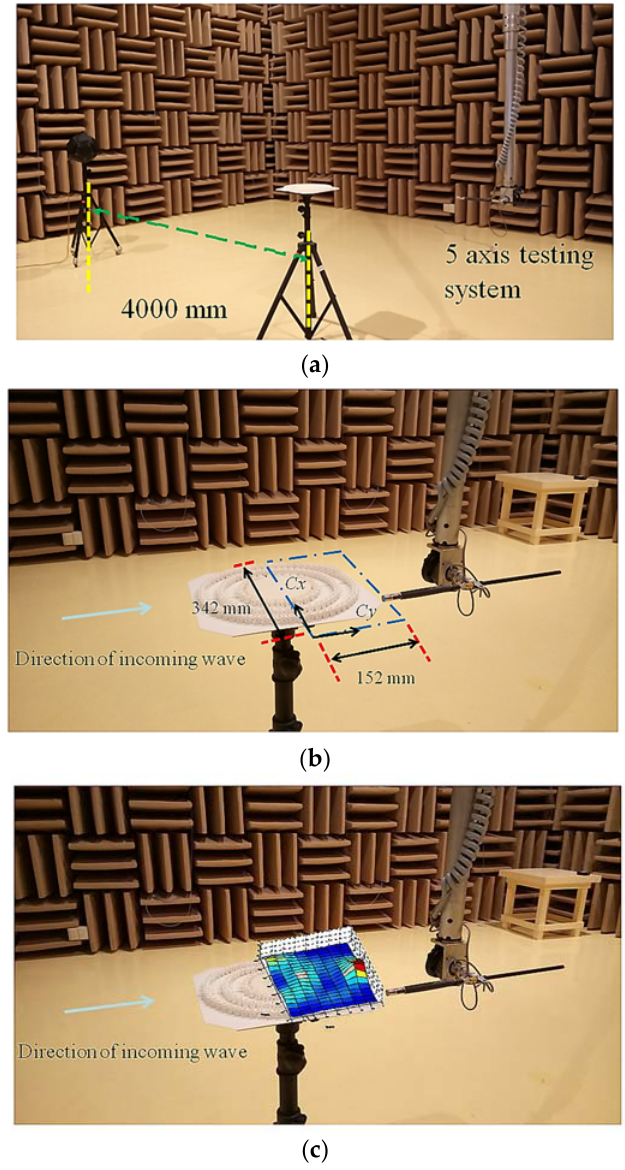
Figure 24. Experimental setup for measurement in a semi ‐ anechoic room: ( a ) the sound source is excited by B&K Type 4296 omni ‐ directional sound source at 2000 Hz apart from test specimen at 4000 mm; ( b ) the near field measurement inside the cloak shell region was measured using a single free ‐ field microphone scanned in the region between Cx = 0~342 mm and Cy = 0~152 mm, as indicated by the dotted line. ( c ) The results indicate the wave propagation behavior inside the half shell region.